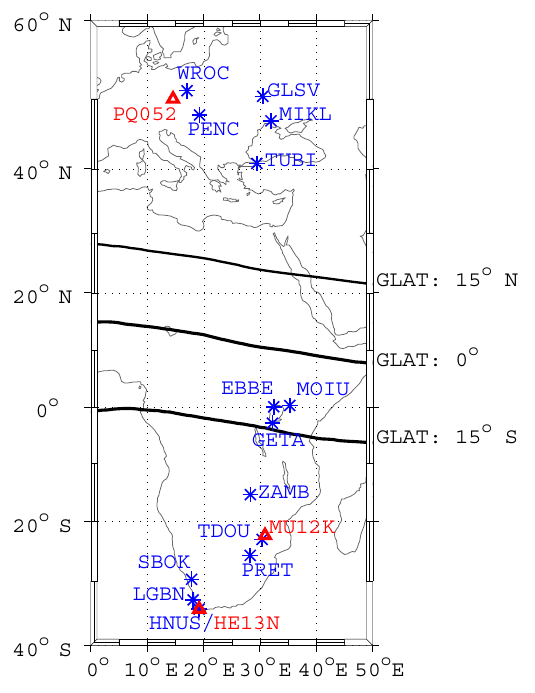
Figure 1. Map showing the locations of GPS (blue ∗ ) and ionosonde (red (cid:77) ) stations used for this study.